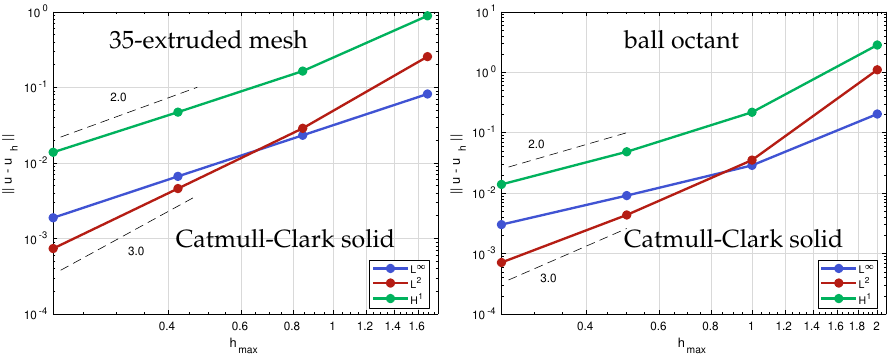
Figure 7. Volumetric Catmull-Clark elements: convergence of the error for Poisson’s equation.